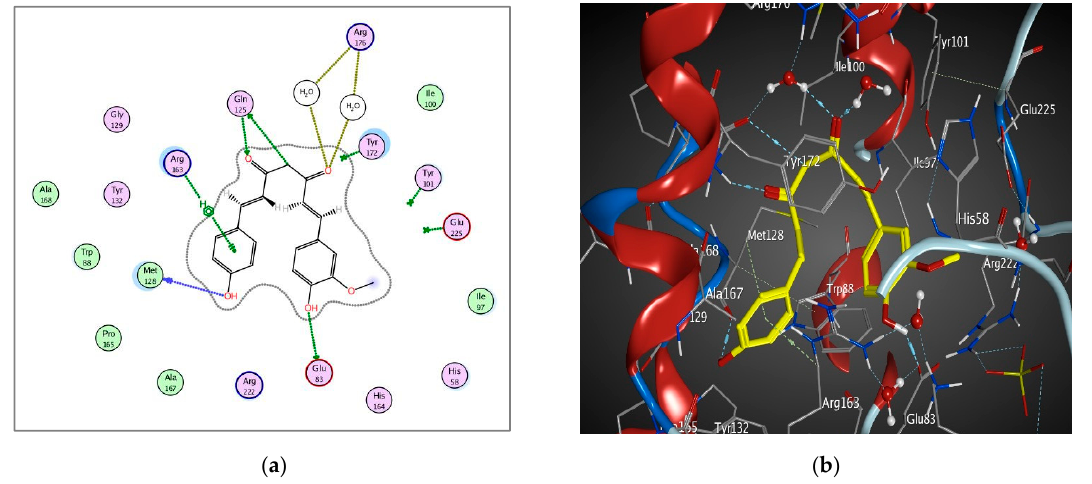
Figure 7. 2D diagram ( a ) and 3D representation ( b ) showing the binding mode of curcumin (yellow) with 1KI4 thymidine kinase binding pocket.